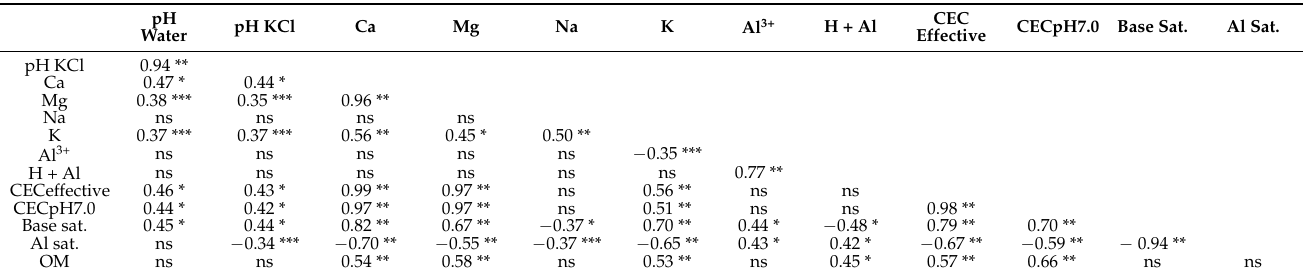
Table 9. Pearson’s correlation between the soil chemical variables of Quartzipsamments of the Southwest of Rio Grande do Sul State, southern Brazil.